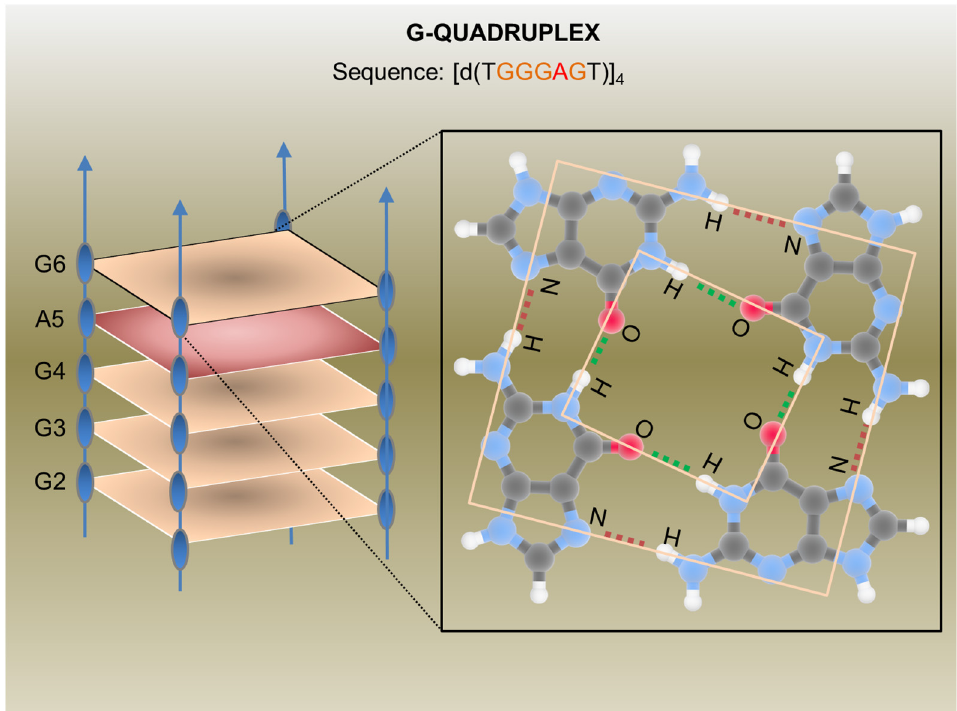
Figure 2. G-Quadruplex aptamer detailed in a report by Virgilio et al.: Schematic representation of the anti-HIV G-Quadruplex aptamers detailed in a report by Virgilio et al. [35] (on the left) and an example of a G-tetrad showing H-bonds (on the right). CC BY 4.0 license